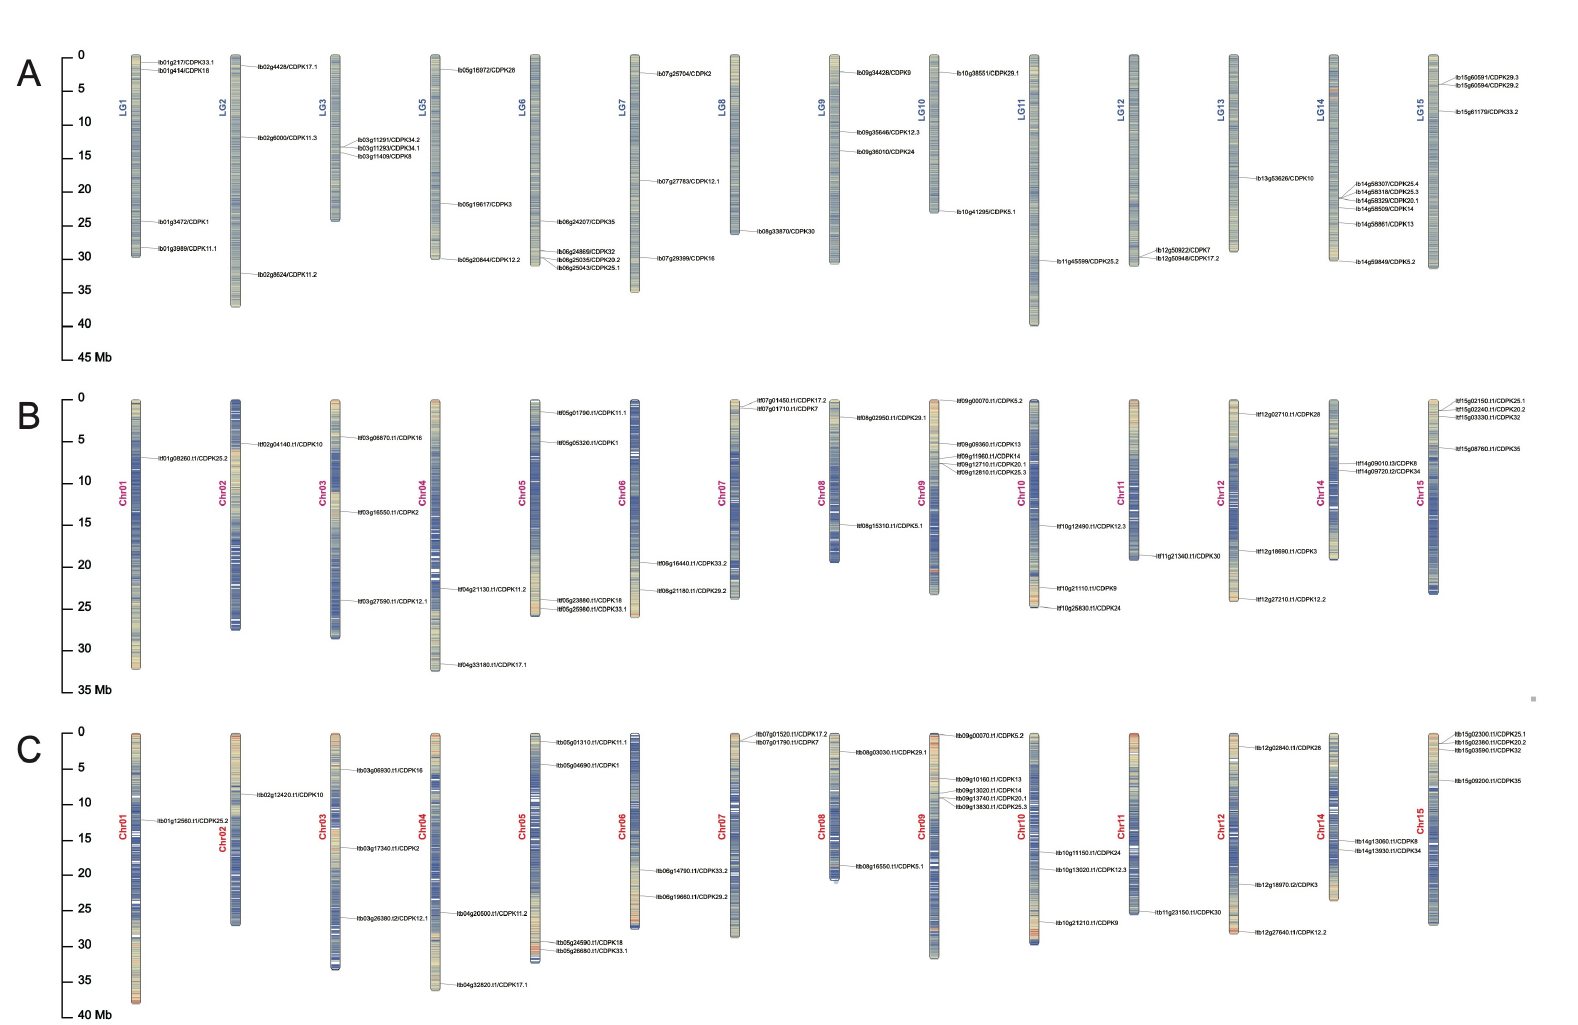
Figure 1. Chromosomal localization and distribution of CDPK genes in I. batatas ( A ), I. trifida ( B ), and I. triloba ( C ). The bars on the left margin represent chromosomes. The chromosome numbers are displayed on the left side of the chromosomes, and the gene names are displayed on the right side. Detail chromosomal location information is listed in Table